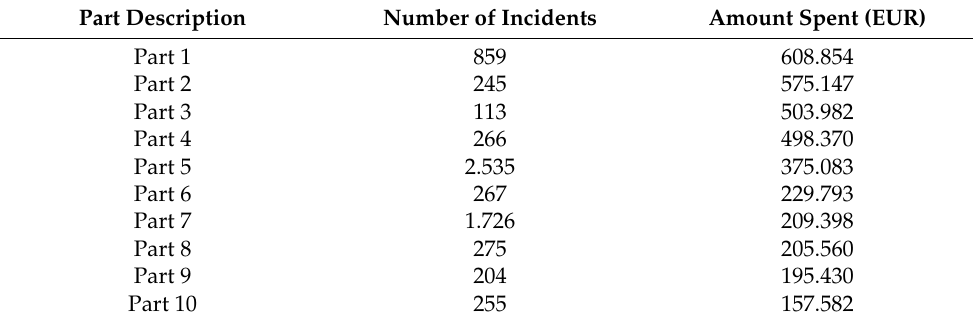
Table 2. Top ten parts (alternatives).